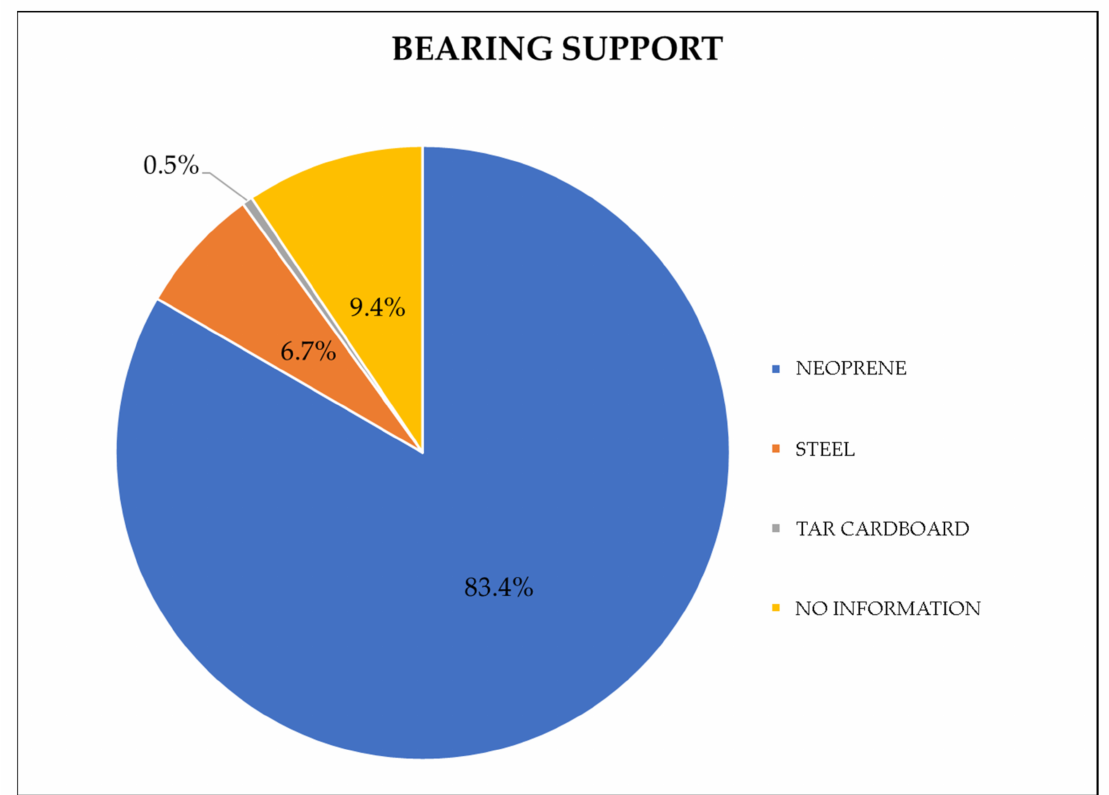
Figure 8. Historical classification of types of Chilean bridges.